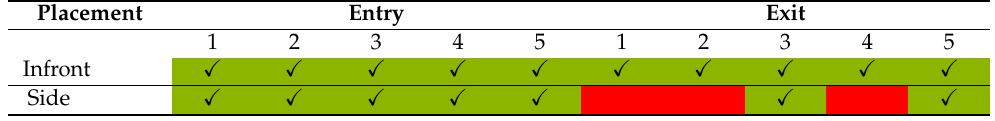
Table 4. Repeatability test with antenna placed in front/at the side of the entrance.